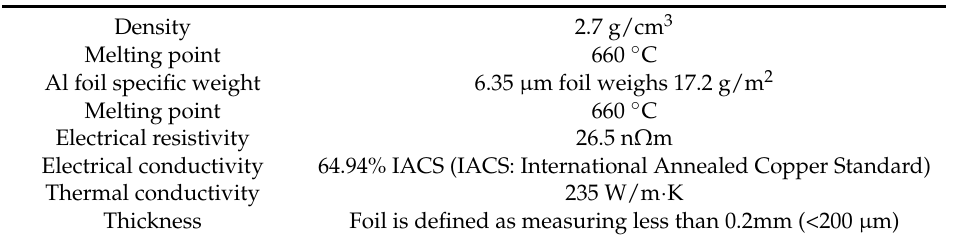
Table 1. Properties of Al Foil sheets used for BRS [45].